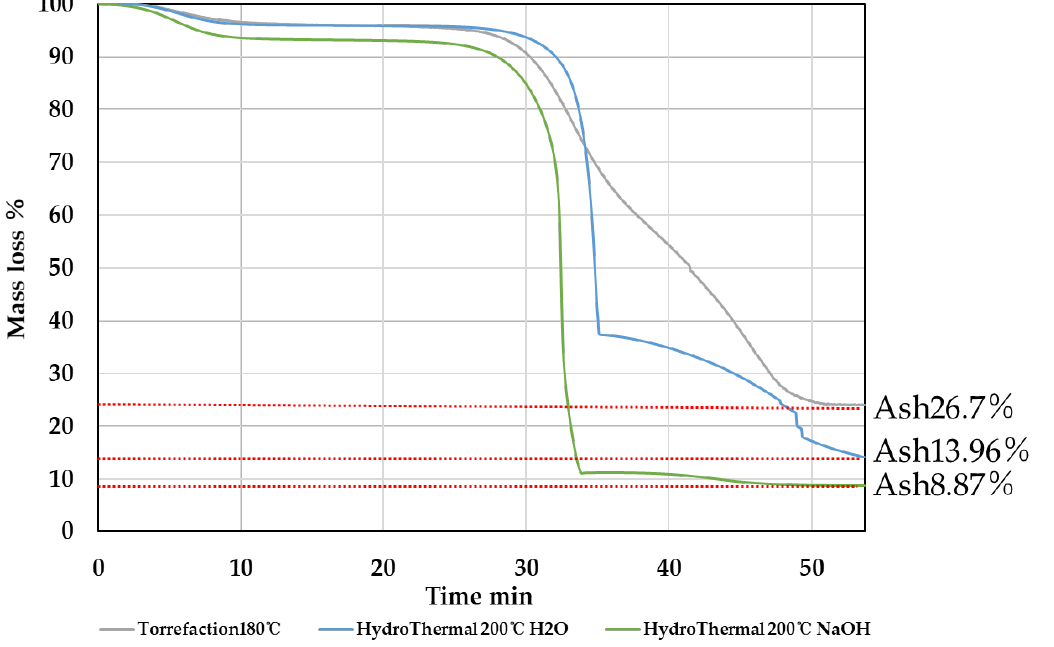
Figure 16. DTA analysis results of the rice husk torrefaction and hydrothermal products.